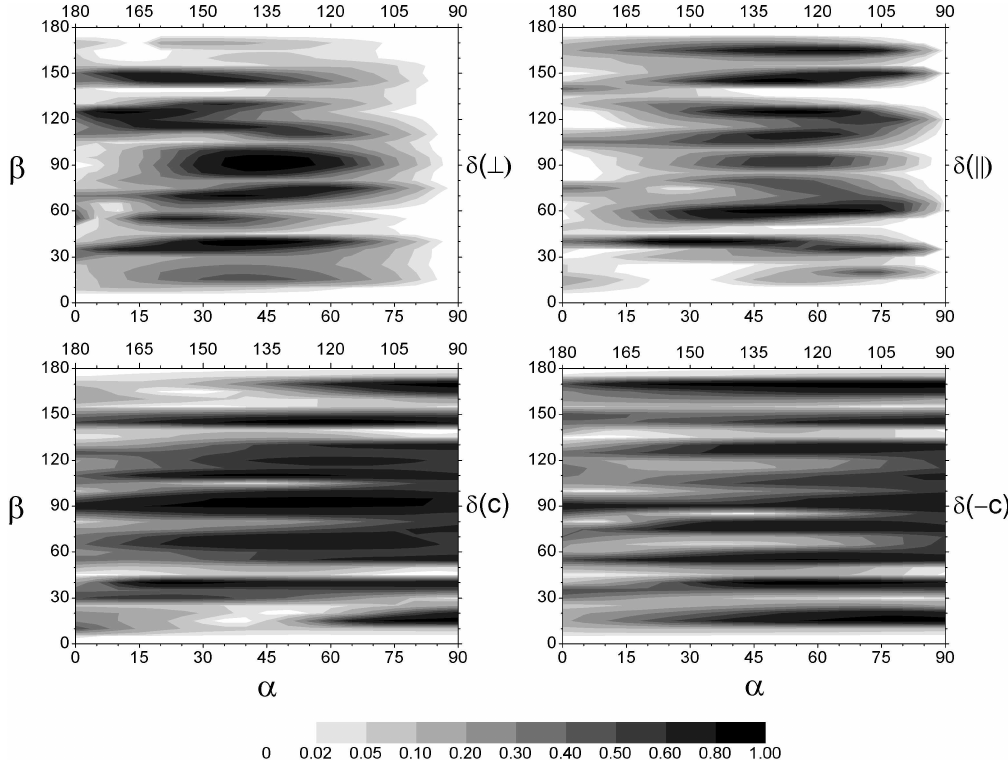
Fig. 1. Linear depolarization ratios δ || , δ ⊥ (upper panels) and circular depolarization ratios δ C and δ − C (bottom panels) for particles with d = 2µm and 0 = 1 at a scattering angle of 175 ◦ as a function of the particle orientation given by the Euler angles α and β . Note that the figure is not area representative due to the cylindrical